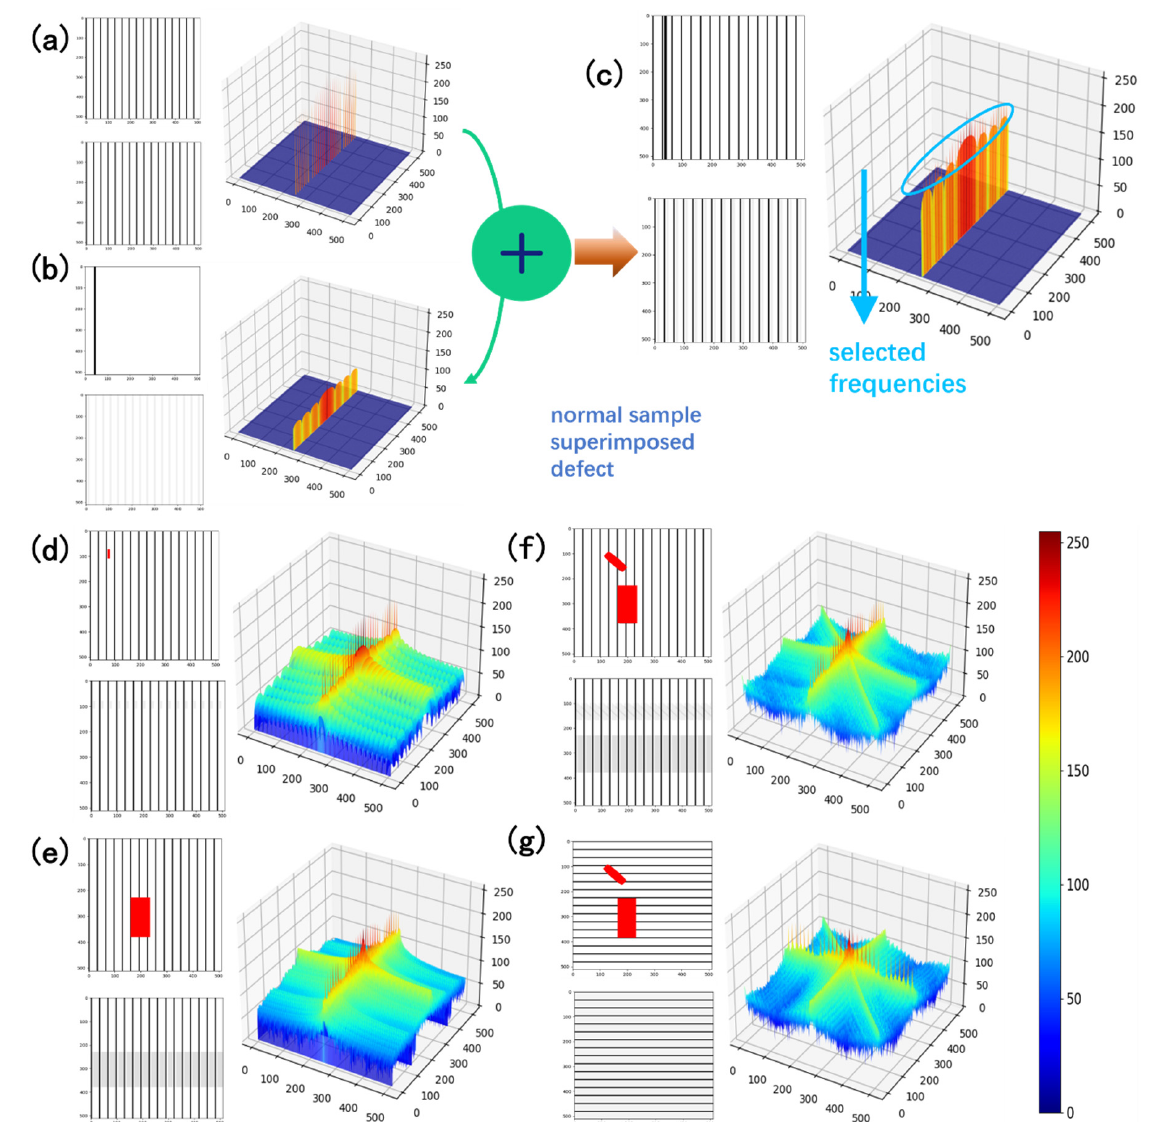
Figure 2. Simulation of the proposed method. Fourier transform spectrum magnitude and recon- structed image after spectrum filtering of ( a ) normal stripe feature, the spectrum is concentrated values along the horizontal axis; ( b ) only defect feature, the spectrum energy is scattered along the horizontal axis; ( c ) normal feature and defect combined, the spectrum is the sum of first two; ( d ) small speckle defect; ( e ) large area defect; ( f ) multiple defects; ( g ) defects on horizontal stripes, filtered with only vertical frequencies; defects can hardly be seen in the reconstructed image although the original defect size is